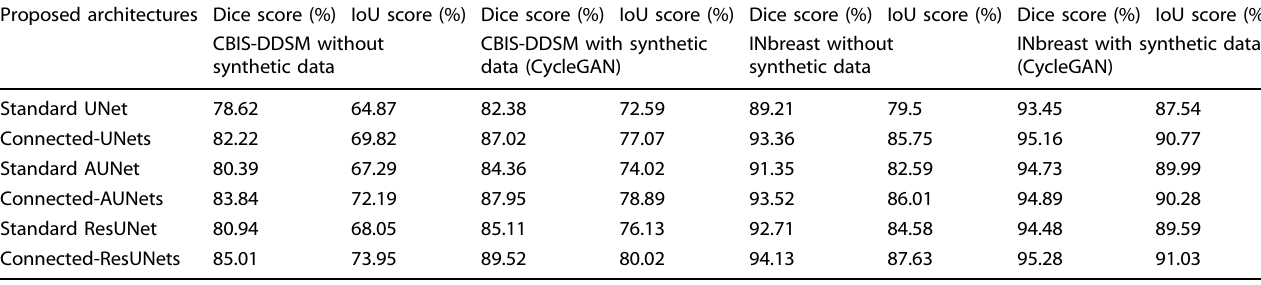
Table 3. Comparison of the proposed architectures after adding synthetic CBIS-DDSM and